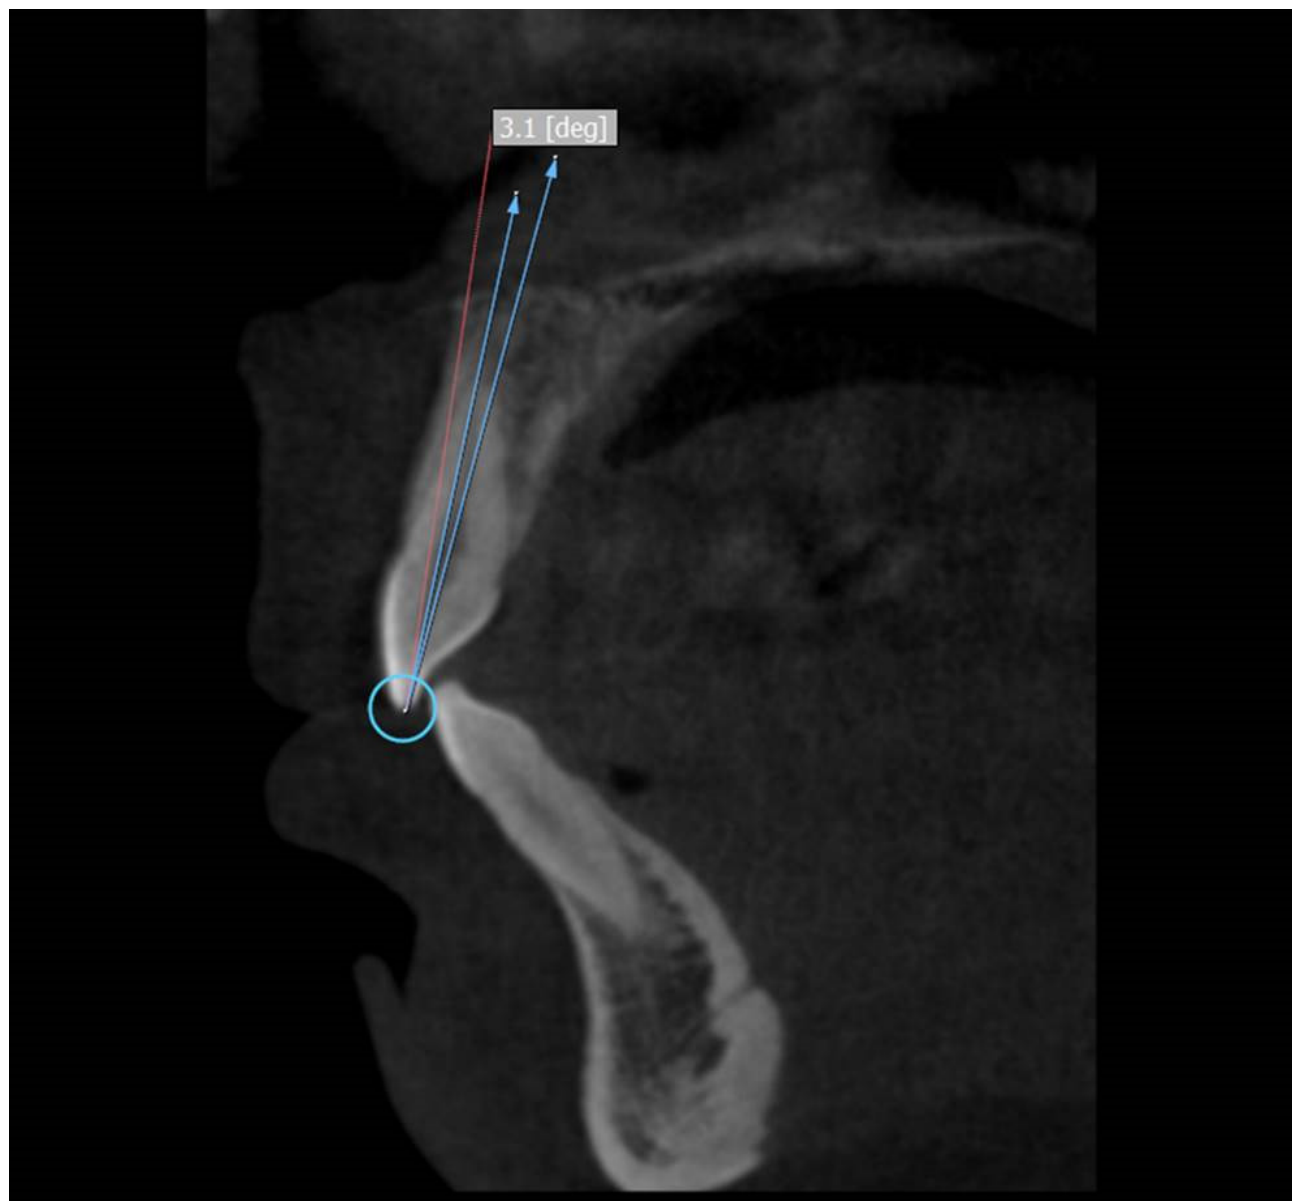
Figure 1. Use of the 3D:OnDemand software to locate the specific points of median sagittal sections for maxillary anterior teeth and to measure crown to root angle.